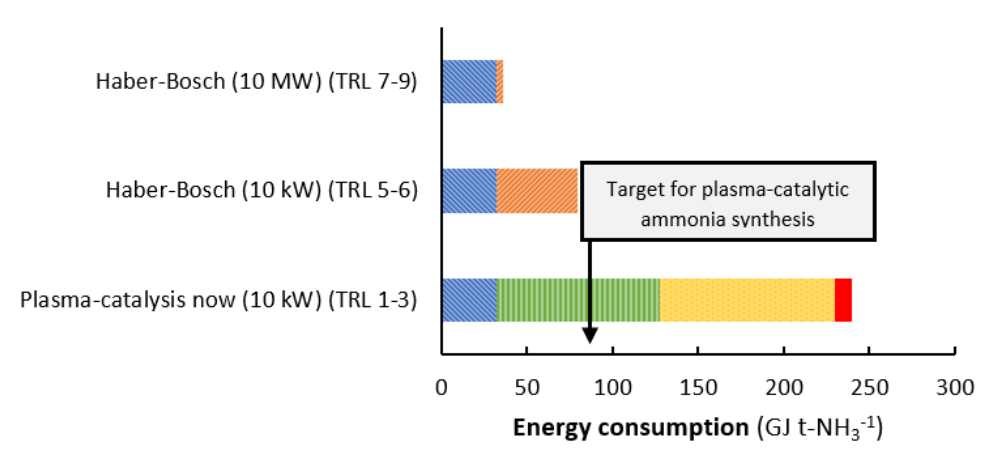
Figure 3. Estimated energy consumption of state-of-the-art, small-scale, electrolysis-based Haber-Bosch, and plasma catalysis. For the Haber-Bosch process, estimates are based on reported energy consumption in Figure 1. For plasma catalysis, the energy consumption for gas recycling and ammonia separation is based on estimates in for low pressure, low conversion systems with solid sorbents as reported in [16,67]. The energy consumption for plasma catalysis is based on data from Kim et al. [43] over a Ru-MgO / γ -Al 2 O 3 catalyst at 0.2% conversion. The energy cost for recycling and separation with solid sorbents is discussed in Section 3.1. Technology readiness level (TRL). The TRL levels here apply for the complete system. TRL 1 is the basic idea, while TRL 9 is a commercial system. For more details, see ref. [68].